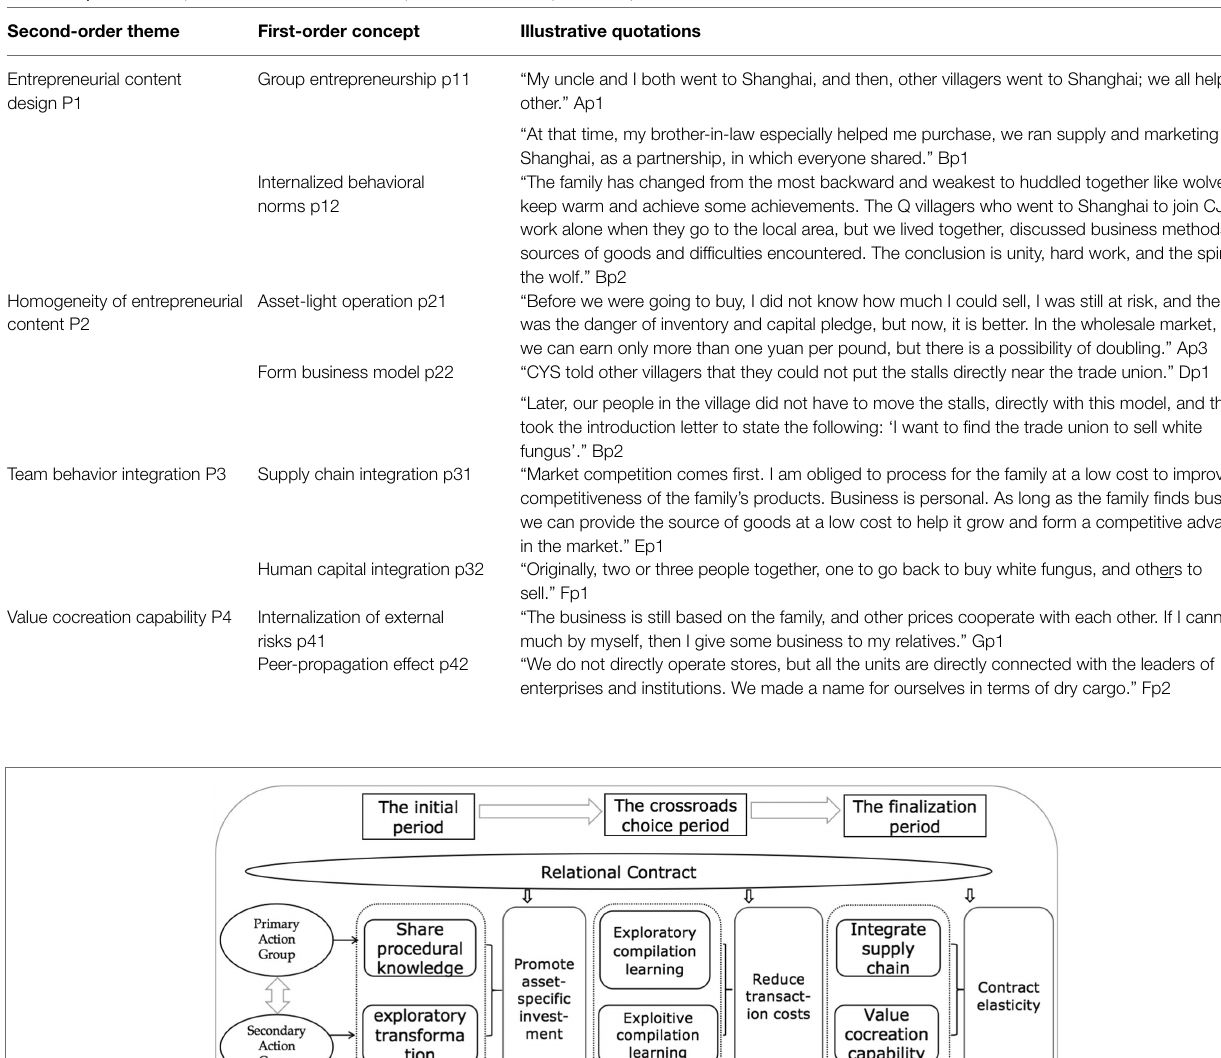
TABLE 5 | Illustrative quotations of first-order concepts in the final entrepreneurial